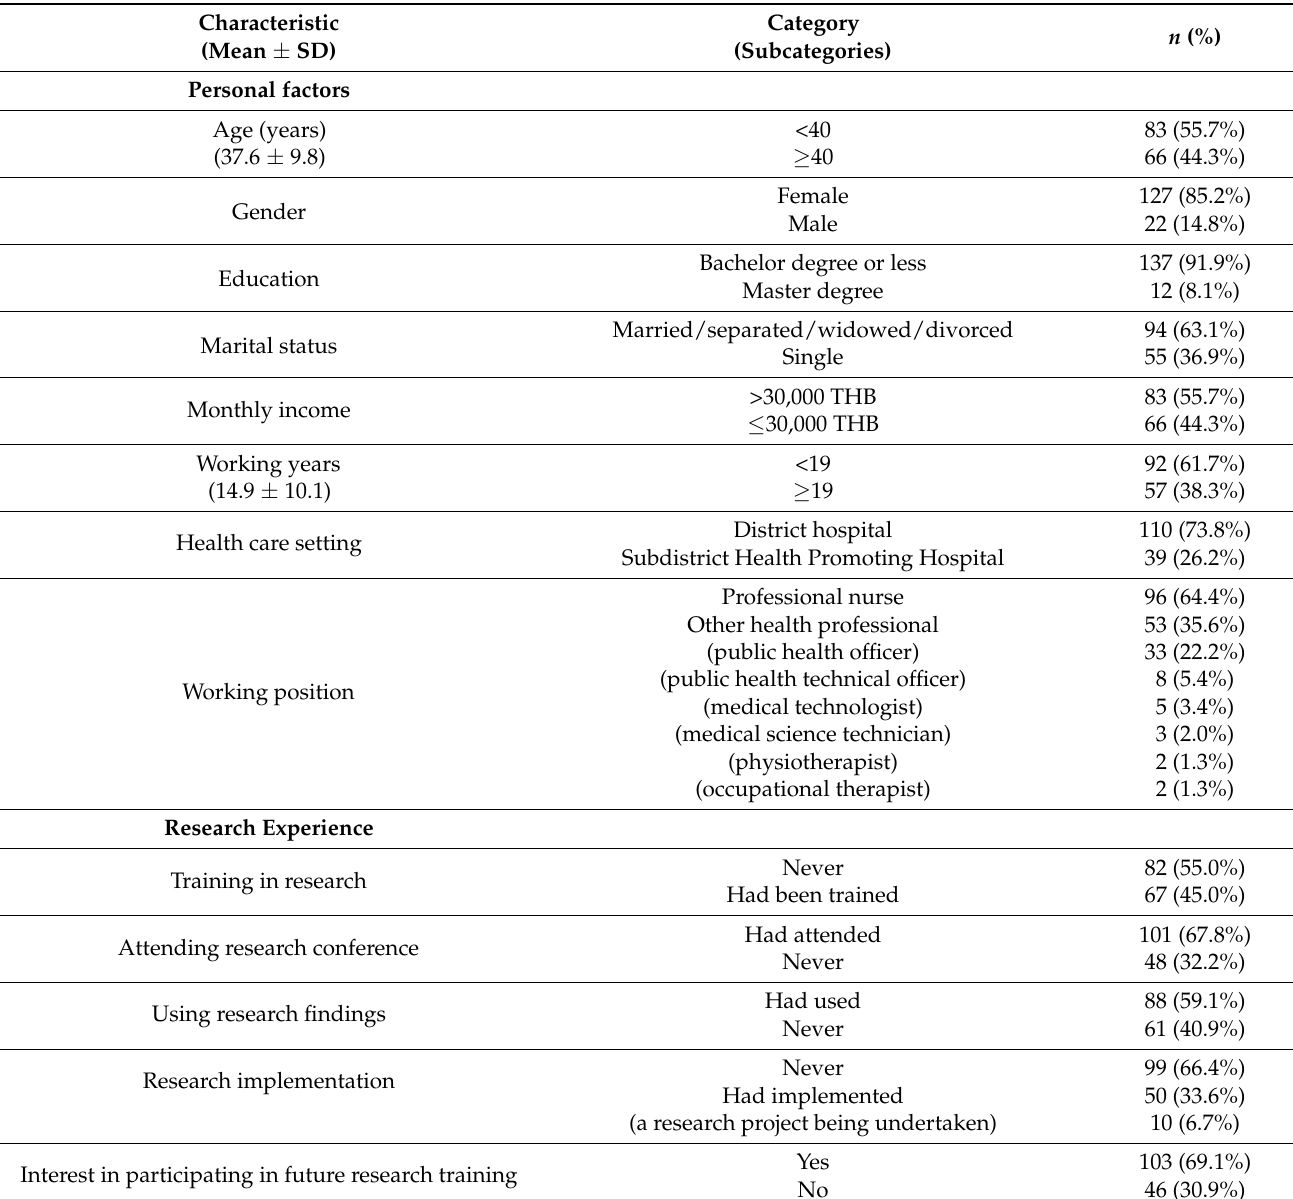
Table 1. Respondents’ personal characteristics and research experiences ( n =